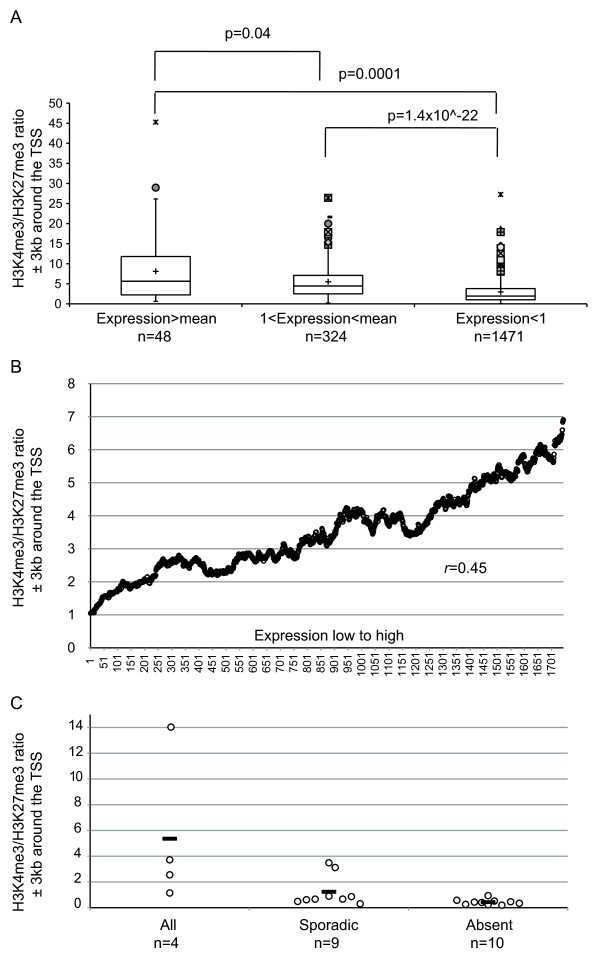
Correlation between expression level and H3K4me3/H3K27me3 occupancy at bivalent genes in embryonic stem (ES) cells. (a) Box plot showing 25th, 50th and 75th percentiles of H3K4me3/H3K27me3 ratio for 1,843 bivalent genes associated with 3 different expression levels, as calculated by Pan et al. [4] (above the mean value for all expressed genes; between the mean value and 1; and below 1). The error bars represent 1.5 times the interquartile range above and below the median. Outliers are plotted individually. The mean of each population is shown as a black cross. Statistical differences were determined using a two-tailed unpaired Student's t test. (b) A total of 1,844 bivalent genes were ranked according to their levels of expression (low to high, x axis) and plotted against the moving average (window size 100 genes, step 1) of the ratios of H3K4me3/H3K27me3 (y axis). Spearman's r value is shown in the graph. (c) Scatterplot showing the H3K4me3/H3K27me3 ratio for 23 bivalent genes associated with 3 different expression patterns as shown by Gibson et al. [29] (present in all the cells analysed, present sporadically in some but not all cells, and absent). The mean of each population is shown as a black bar. The H3K4me3/H3K27me3 ratio has been calculated from the signal derived from the number of H3K4me3 and H3K27me3 sequence reads in an area spanning from -3 kb to +3 kb around the transcription start site (TSS). Statistical analysis made with different windows (from -4 kb to +1 kb and from -0.5 kb to +2 kb) gave similar results.